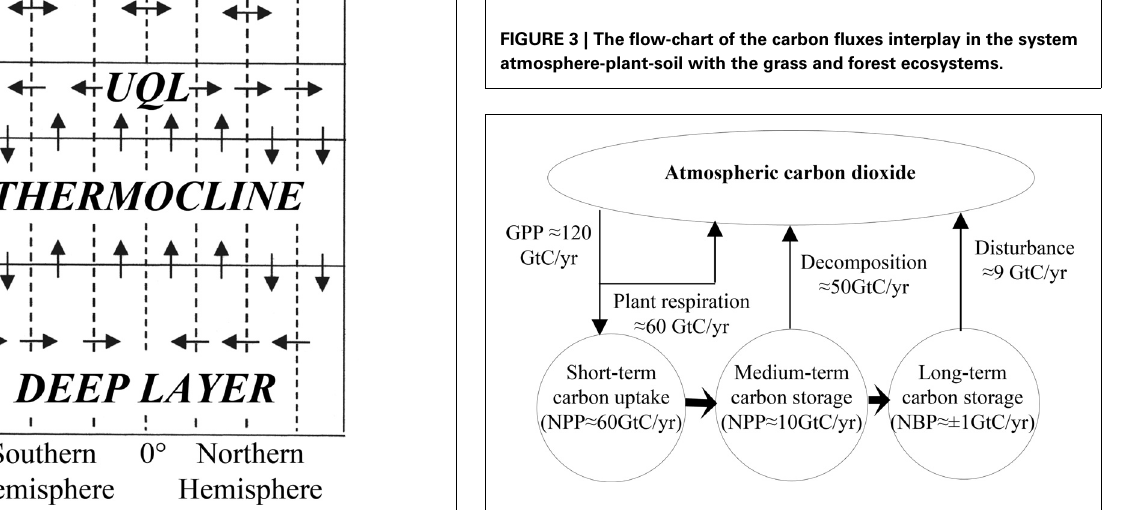
FIGURE 2 | Schematic pathways of the circulation in the World Ocean for the mapping of carbon cycles considering the upper quasi-homogeneous layer (UQL).